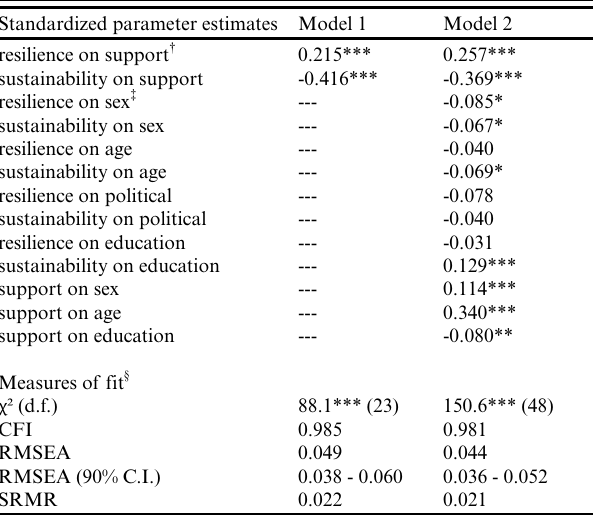
Table 3 . Parameter coefficient estimates and measures of model fit for structural equation